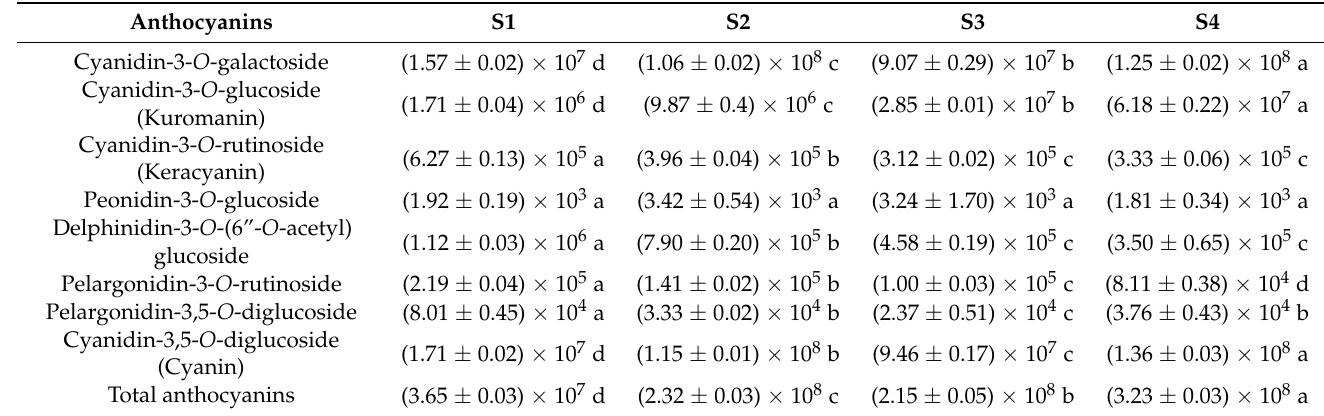
Table 1. Anthocyanin composition and content during the ripening of Z. bungeanum fruit.